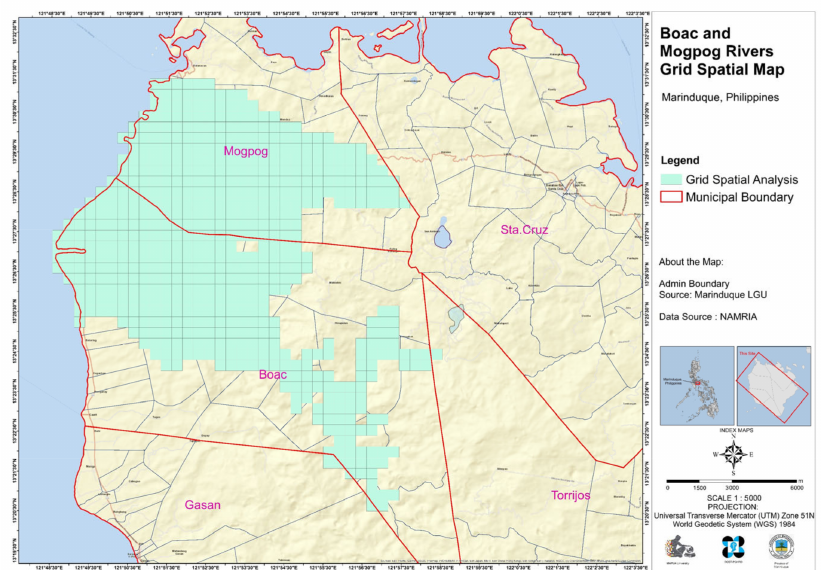
Figure 5. Spatial Grid map of the floodplains of Boac and Mogpog rivers.